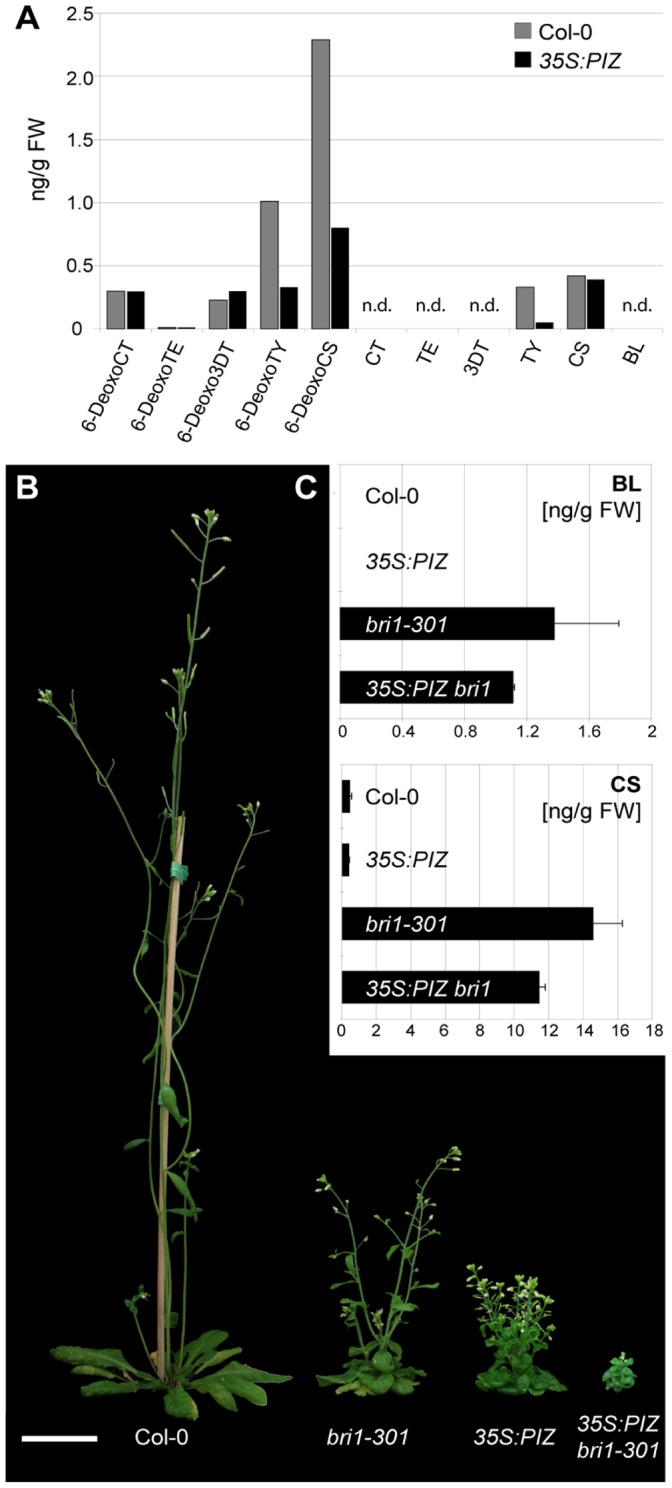
Endogenous BR levels in 35S:PIZ and 35S:PIZ bri1-301 seedlings.(A) Free BR levels in aerial tissues of 4-week-old 35S:PIZ seedlings quantified by GC-MS are shown in ng/g fresh weight (FW). 6-deoxo-cathasterone (6-deoxoCT), 6-deoxo-teasterone (6-deoxoTE), 3-dehydro-6-deoxoteasterone (6-deoxoDT), 6-deoxo-typhasterol (6-deoxo-TY), 6-deoxo-castasterone (6-deoxoCS), cathasterone (CT), teasterone (TE), 3-dehydro -teasterone (3DT), typhasterole (TY), castasterone (CS), brassinolide (BL). n.d., not detected. (B) Growth phenotypes of 17-day-old Col-0, bri1-301, 35S:PIZ and bri1-301 35S:PIZ (from left to right). Scale bar represents 3 cm. (C) Free BL and CS levels from aerial tissues of 17-day-old plants are analysed by LC-ESI-MS/MS. Mean values of three biological replicates are shown, relative to fresh plant weight (FW), with SD.